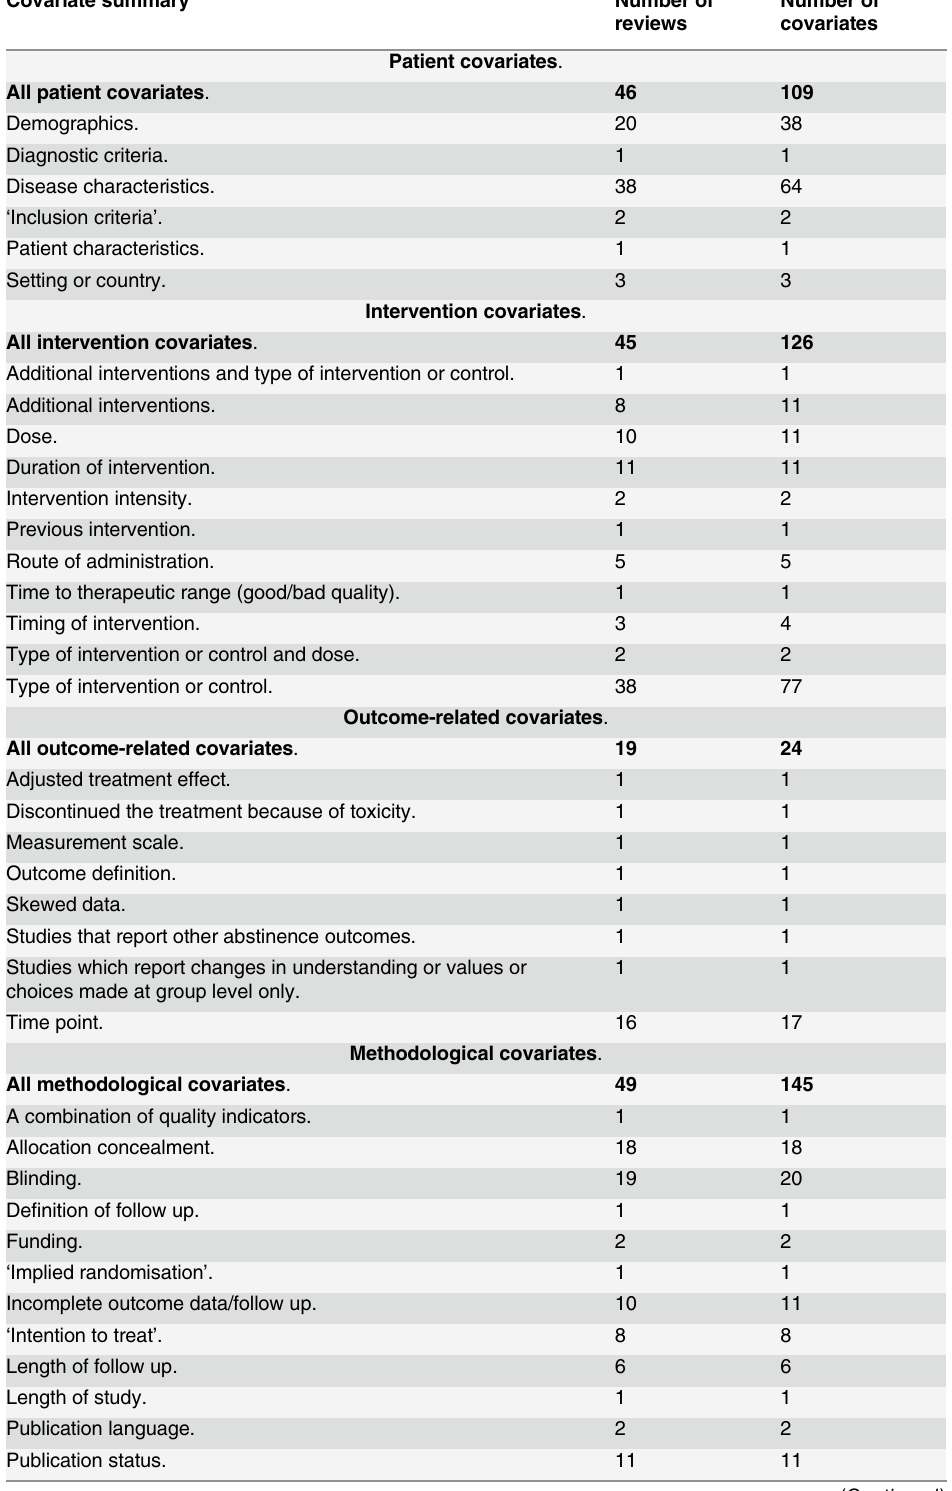
Table 2. Summary of